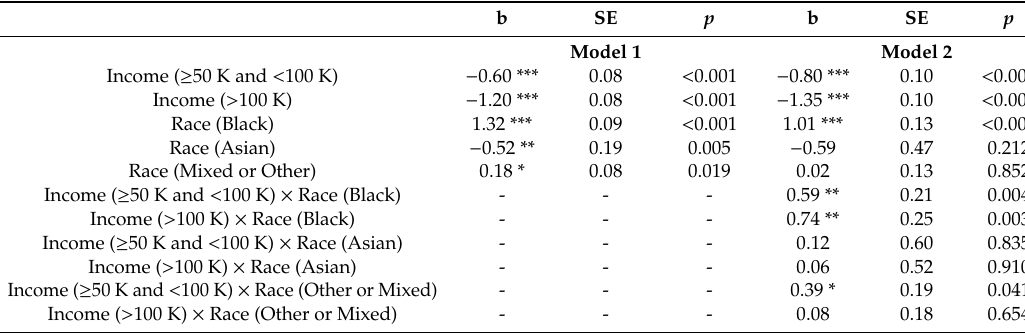
Table 3. Mixed-e ff ects regressions overall ( n = 15,022).